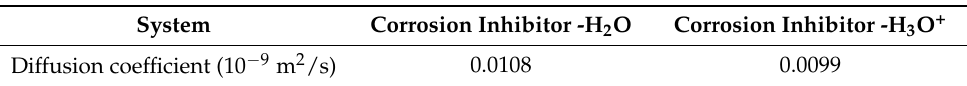
Table 3. Diffusion coefficient of two corrosion media particles in the inhibitor film, the self-diffusion coefficient of water is 2.34 × 10 − 9 m 2 /s.